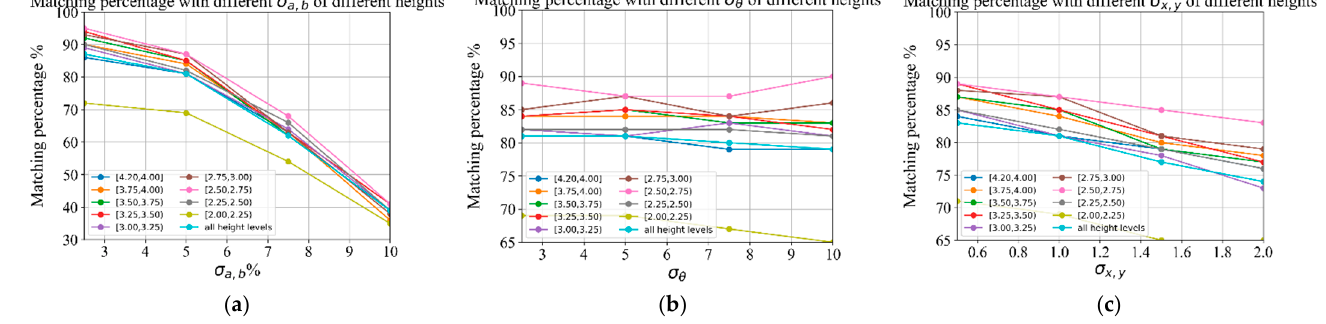
Figure 18. Matching percentage with different noise for different heights. [4.2, 4.0] in the legend indicates that the altitude range was between 4.2–4 km.